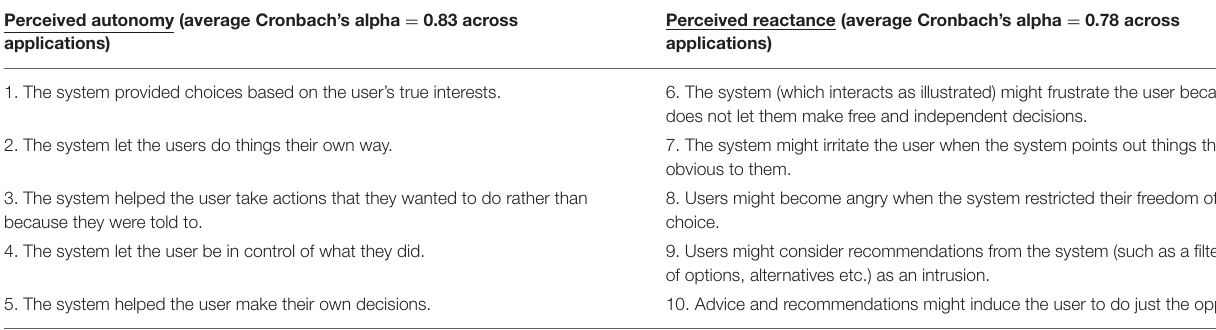
TABLE 3 | Statements to assess perceived autonomy and